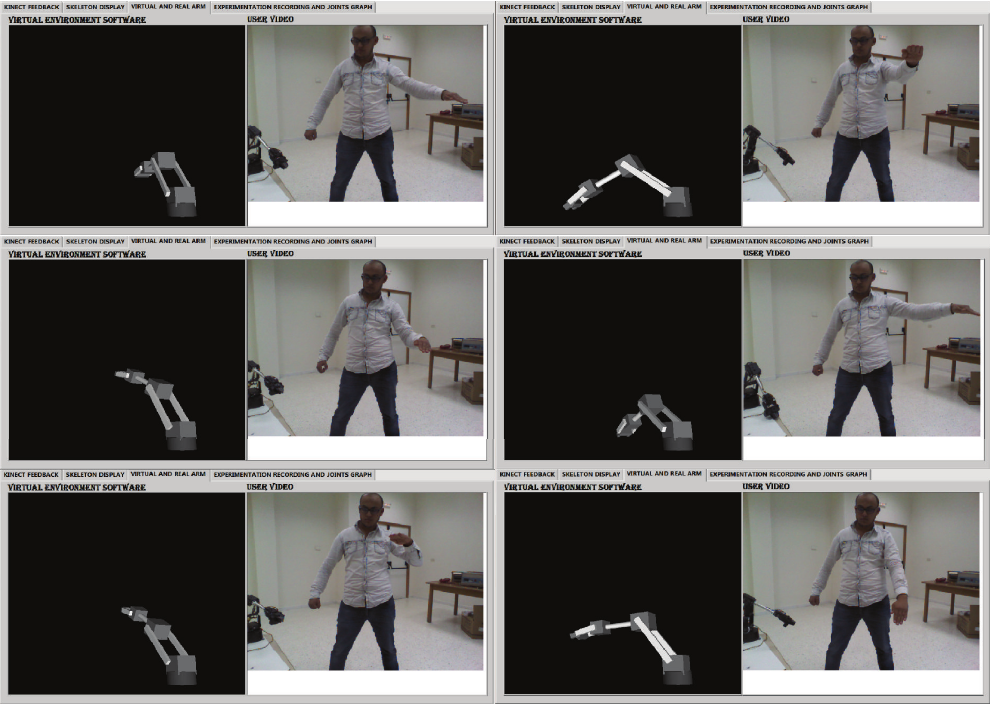
Figure 12: Augmented reality process.